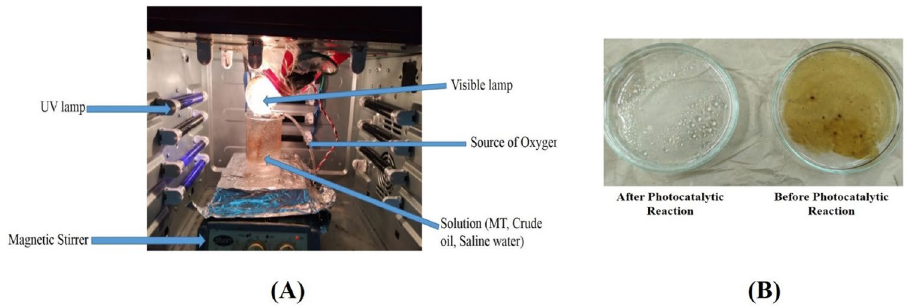
Figure 6. Photo-degradation study of (crude oil/saline water) samples by using different prepared MOF samples (18 MT, 48 MT).